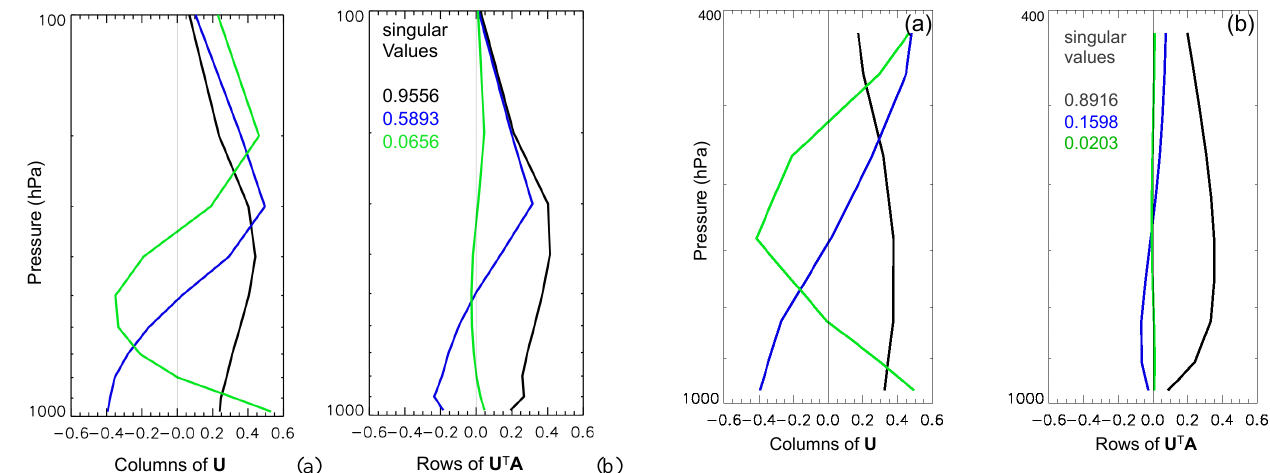
Fig. 6. Same as Fig. 5, but for the SVD of the TES-OMI CONUS average O 3 Figure 6. same as Figure 5, but for the SVD of the TES-OMI CONUS average O AK. 3